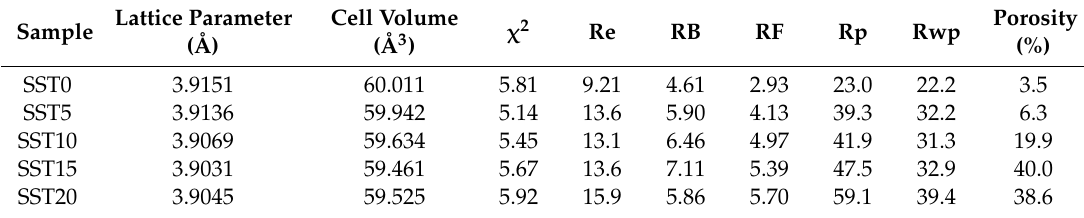
Table 1. The lattice parameter, cell volume, Rietveld refined parameters, and porosity of the studied